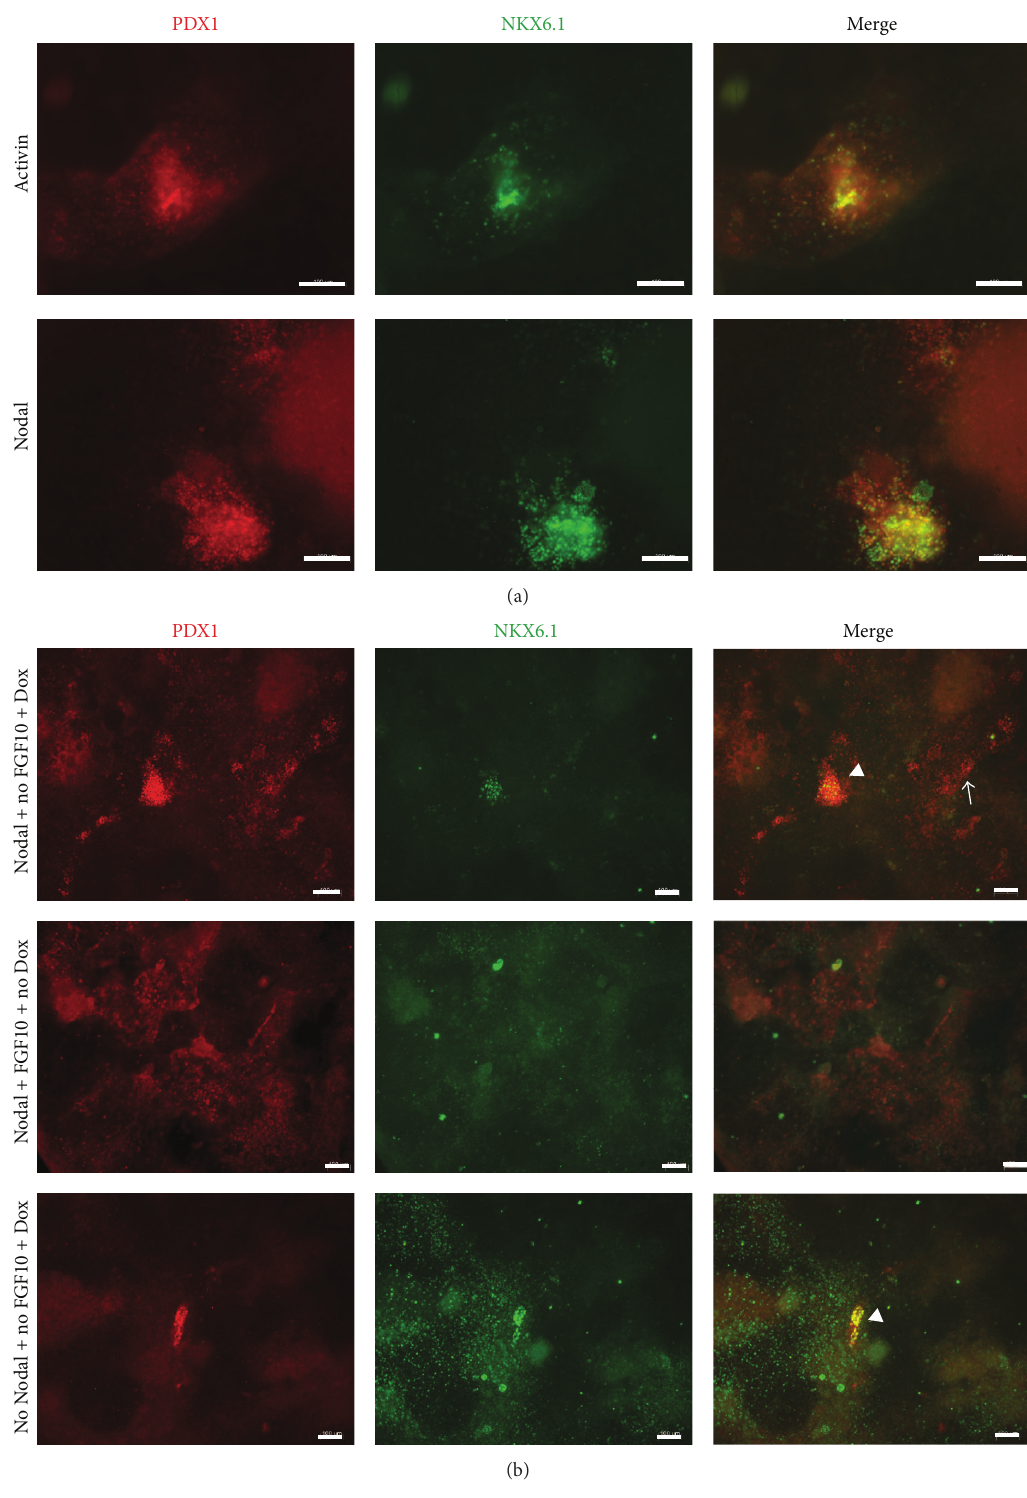
Figure 4: PTF1a induction in combination with FGF10 led to the formation of pancreatic epithelial progenitors. (a) Both Nodal and Activin A derived posterior foregut endoderm generated PDX1 + NKX6.1 + pancreatic progenitors on induction of PTF1a along with FGF10 treatment. Uninducedculturesdidnothaveanysuchcopositivearea(datanotshown).(b)Nkx6.1andPdx1copositivepancreaticprogenitorswereunique to PTF1a induced cultures (top and bottom row). FGF10 was not necessary to generate PDX1 + NKX6.1 + population, although it increased the numbers of such progenitors (top row). Notably, FGF10 alone did not produce any NKX6.1 + cells (middle row), and hence PTF1a induction is essential for the formation of this pancreatic progenitor population. Arrowheads indicate PDX1 and NKX6.1 double positive costained population. Arrows indicate PDX1 single positive cells. Scale bars, 100 𝜇